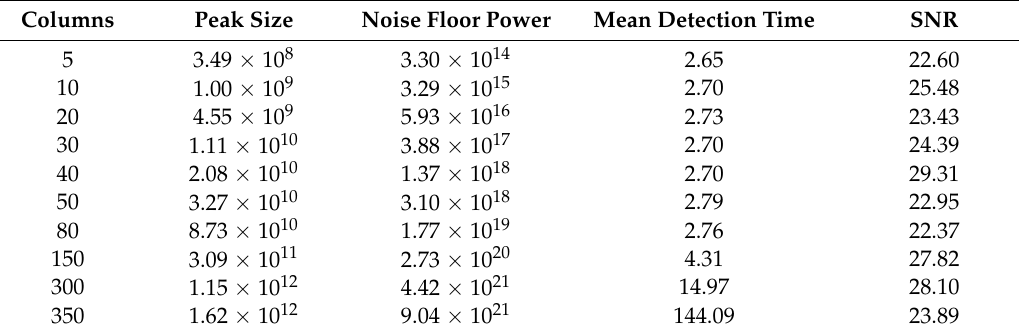
Table 5. Mean detection time and SNR, Dataset